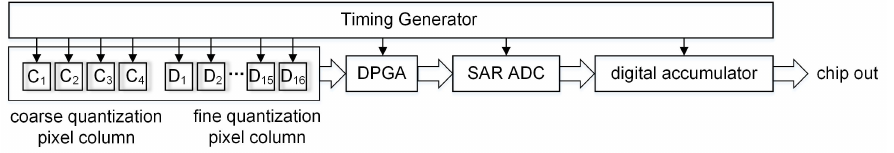
Figure 7. Block diagram of the 16-stage low power digital domain CMOS TDI image sensor chain.